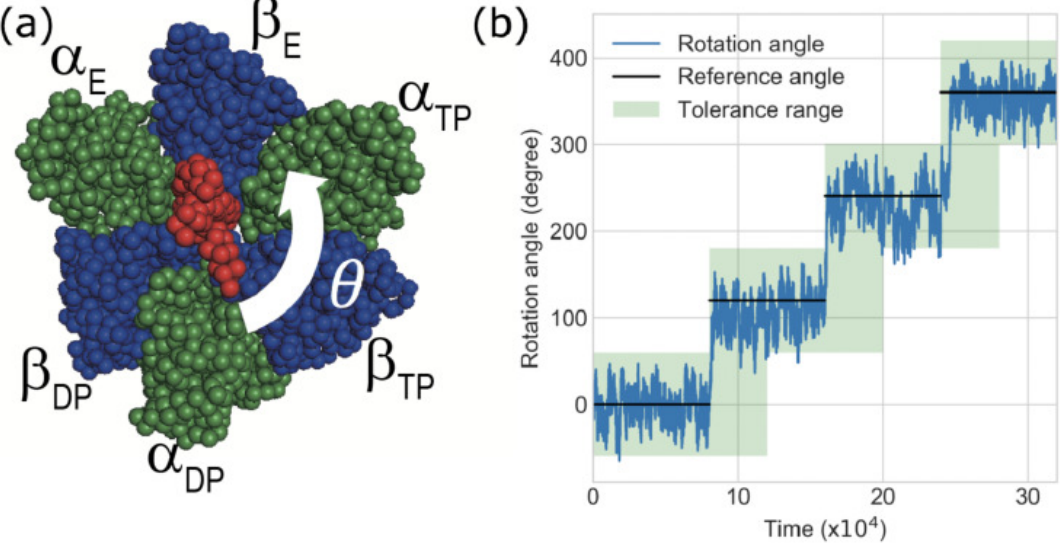
Figure 2. ( a ) Structure of F 1 -ATPase motor and counterclockwise rotation angle θ from initial structure. The red part corresponds to γ -subunit, and the blue and green parts correspond to the β and α subunits, respectively. ( b ) Example of time-series of the rotation angle θ . Black lines indicate the switched angle, referred to as the reference angle of the gamma-subunit in coarse-grained (CG)-molecular dynamics (MD) simulations. The light-green region shows the proper angle region, which is referred to as the tolerance angle. The goodness score of F1-motor rotation is defined as the ratio of the angle θ s in the tolerance